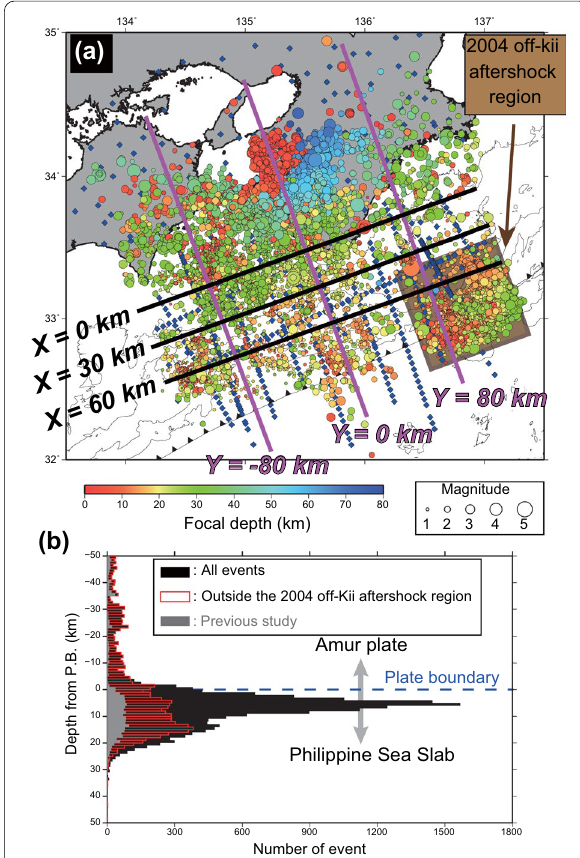
Fig. 5 Hypocenter relocation results. a Map of the relocated hypocenters. Brown rectangle shows the aftershock area of the 2004 off-Kii earthquake. b Histogram of the depth distribution regarding the plate boundary model (Nakanishi et al. 2018). Black, red, and gray correspond to all data, outside of the aftershock area denoted in a , and from Yamamoto et al. (2017),